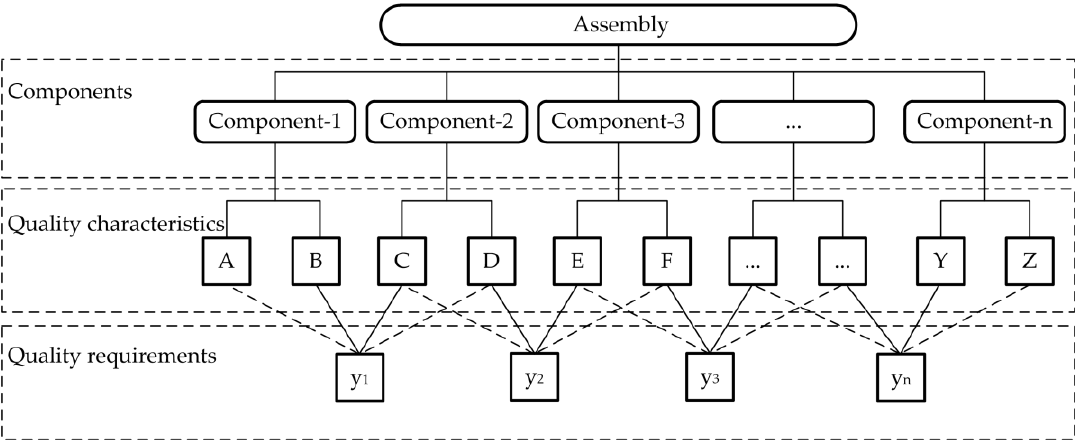
Figure 1. Assembly structure relationship of CMPs.